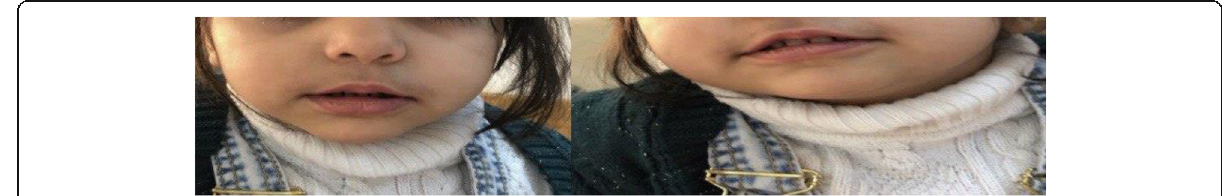
Fig. 1 A baby with intellectual disability, speech delay, broad bridge nose, cupid-bow-shaped upper lip, and a happy